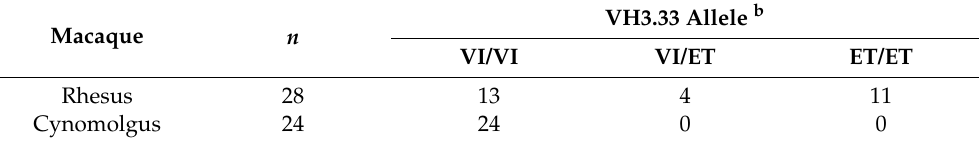
Table 1. Germline Ig VH3.33 polymorphisms in rhesus and cynomolgus macaques a . VH3.33 Allele b Macaque n VI/VI VI/ET ET/ET Rhesus 28 13 Cynomolgus 24 24 0 0